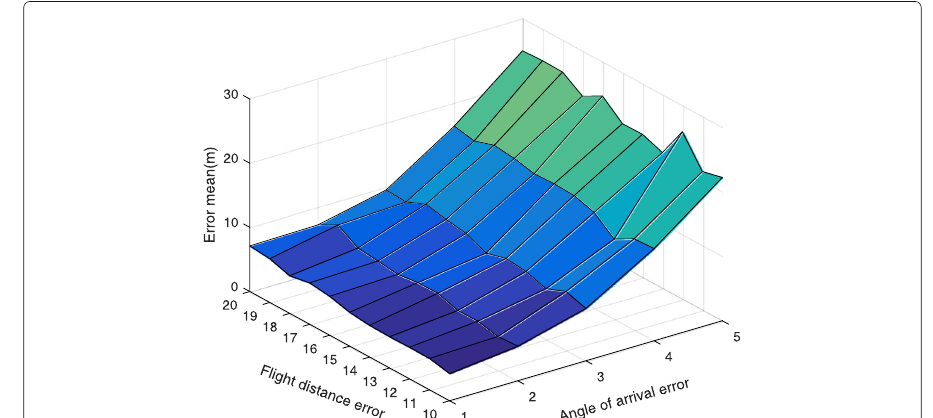
Fig. 10 Influence of parameter measurement error on the